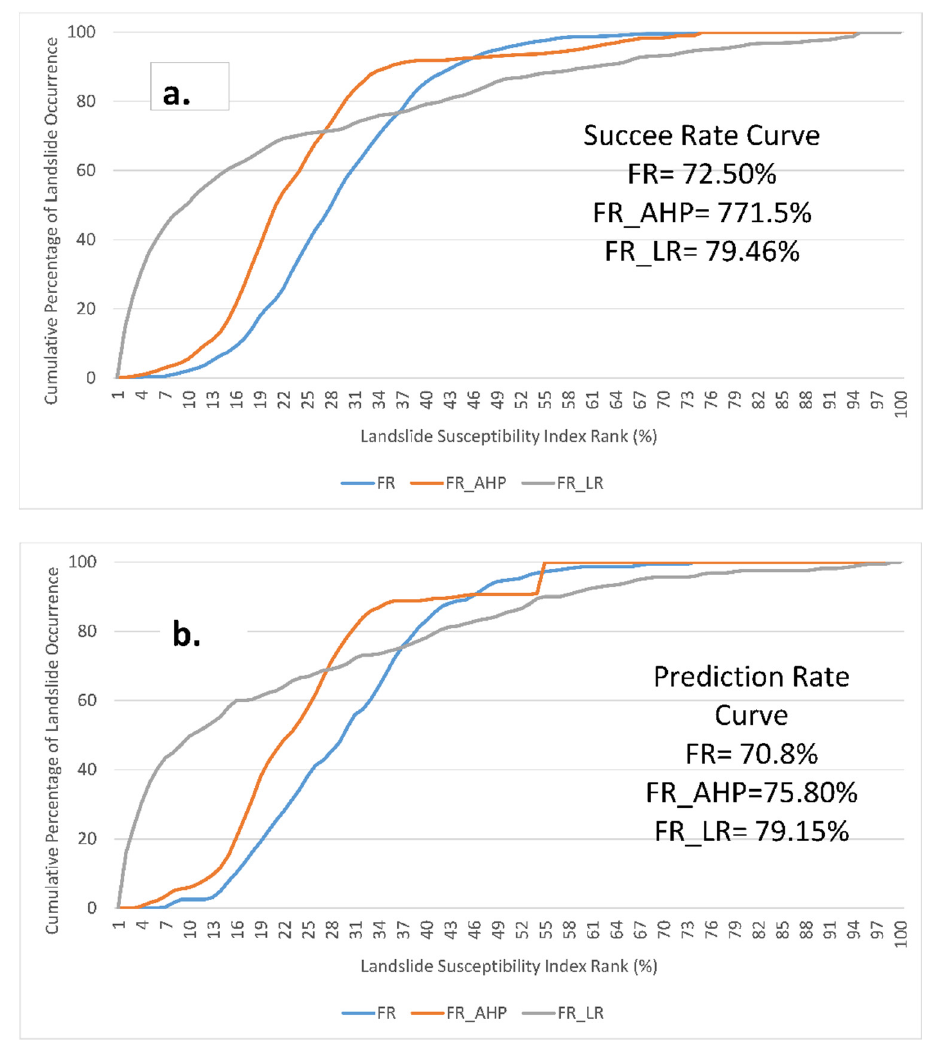
Table 8. Overall correlation between landslide susceptibility models.